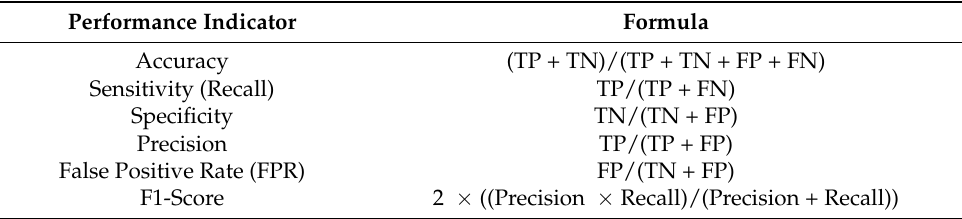
Table 4. Evaluation metrics (TP is true positive, TN is true negative, FP is false positive, FN is false negative).